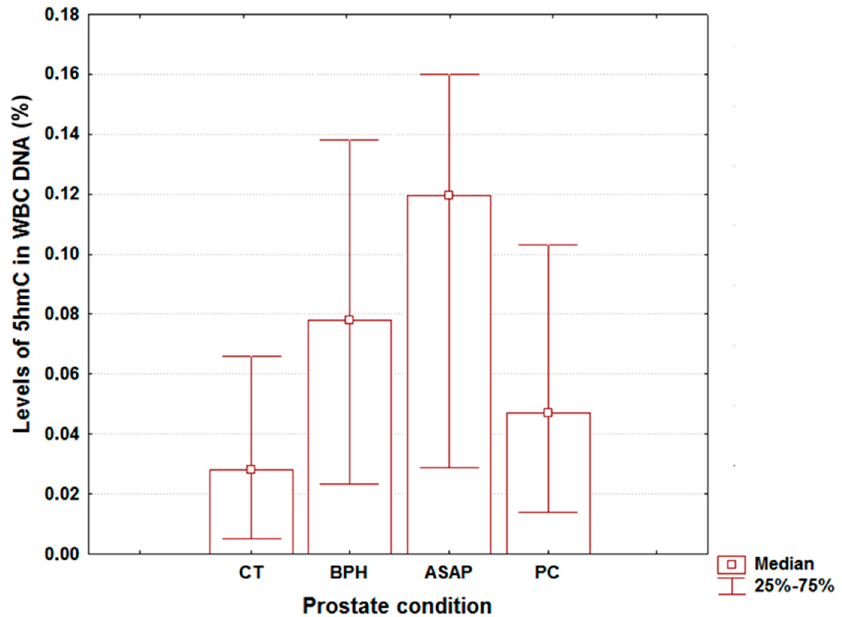
Figure 1. Measured values for 5hmC levels in white blood cells (WBC) DNA from patients with different prostate pathologies. Data are shown as medians with lower and upper quartiles (in paranthesis). CT, controls; BPH, benign prostatic hyperplasia; ASAP, atypical small acinar proliferation; PCa, prostate cancer.